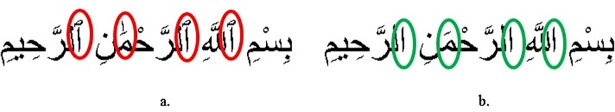
(a) Uthmanic style (b) Plain writing style verse.